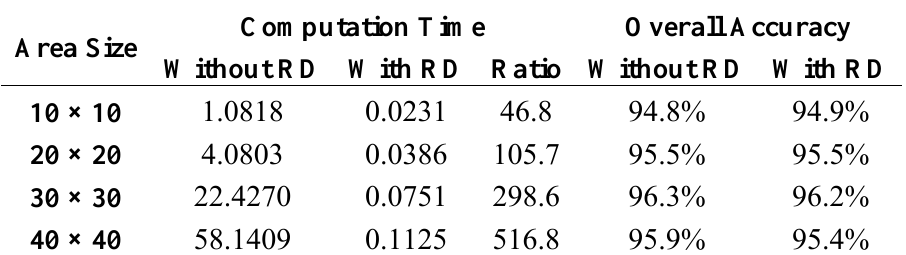
Table 8. Comparison of PNN with and without our weights/biases setting (RD denotes Random